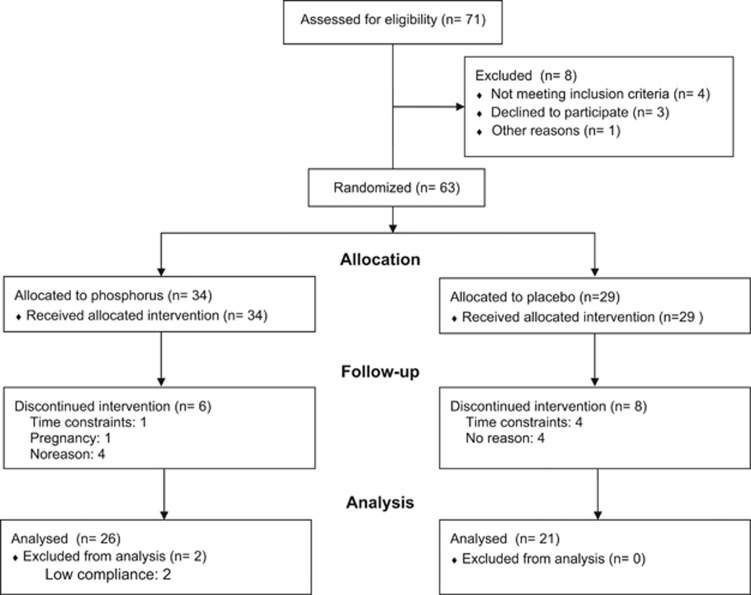
Study flow diagram.